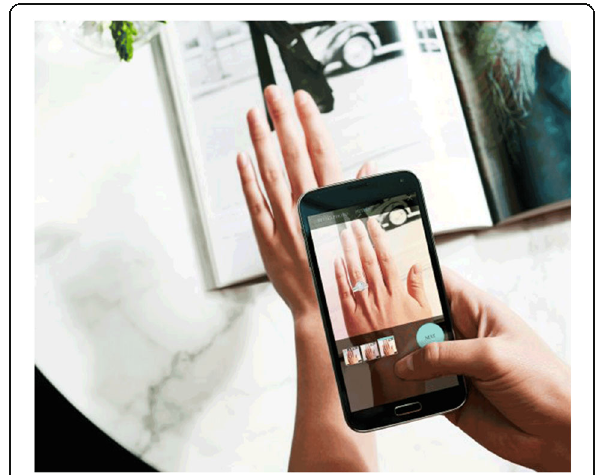
Fig. 9 AR-based mobile app for online